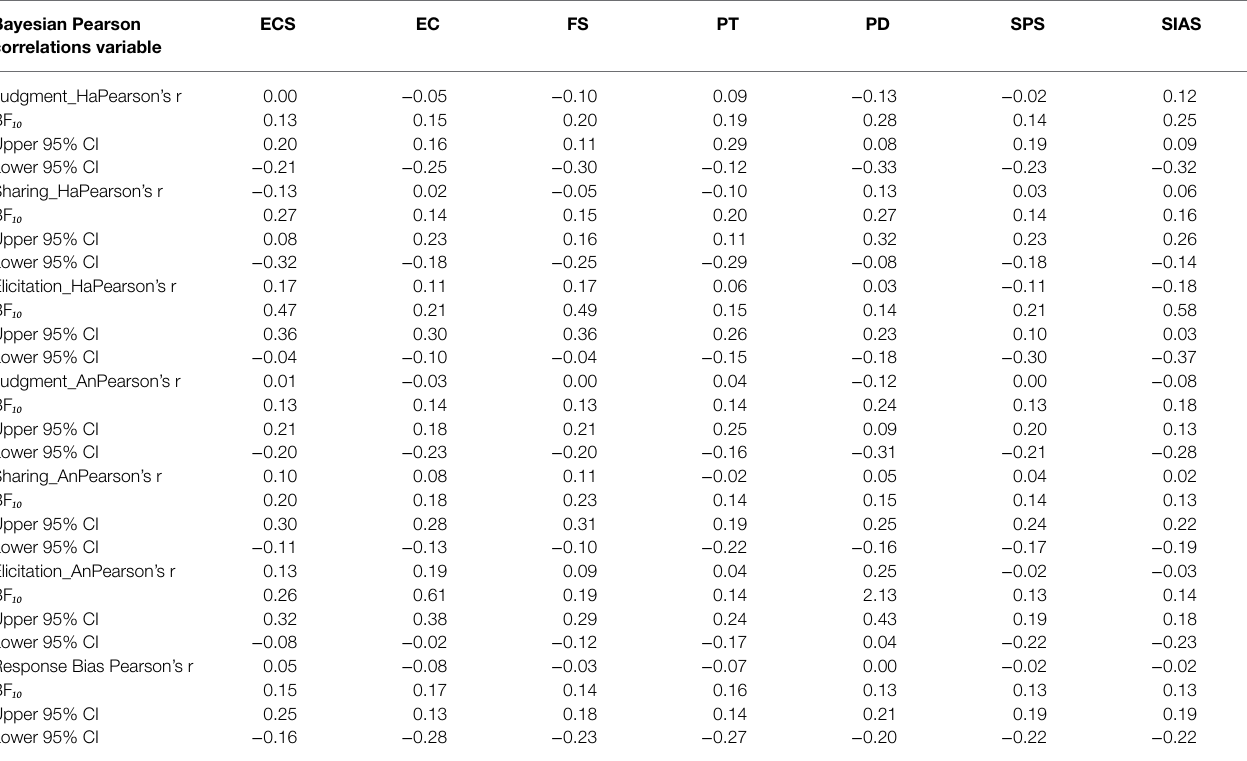
TABLE 5 | Bayesian Pearson correlations between the underlying parameters from the MPT model and the rated subscale using questionnaire. Bayesian Pearson correlations